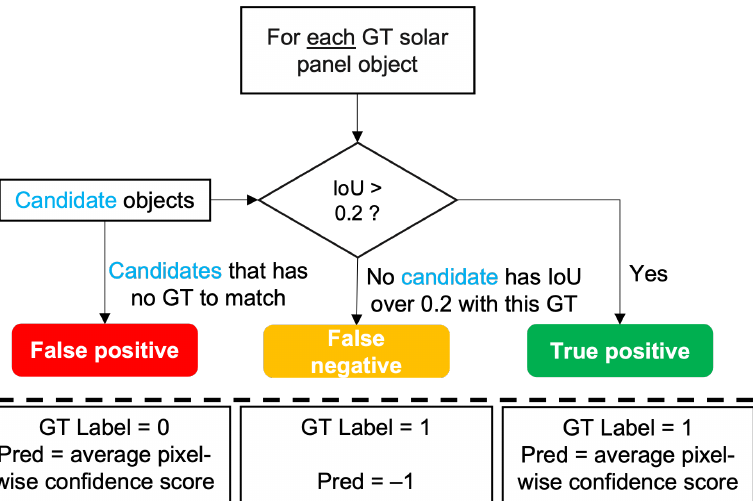
Figure A2. Scoring process. (GT: ground truth). After post-processing, the candidate object groups are matched with the ground truth labels. The confidence score of each object is denoted as the average confidence value of all the pixels associated with that object.